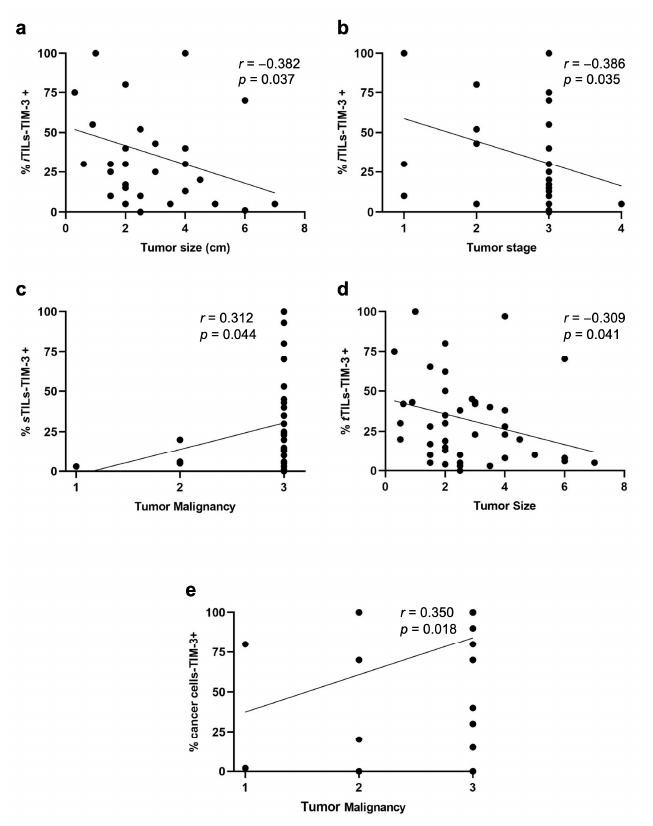
Figure 2. Spearman’s correlations of TILs-TIM-3+ with different tumor locations (intra-tumoral, stromal, and total) and cancer cells-TIM-3+ and their association with clinicopathological features. The percentage of iTILs-TIM-3+ negatively correlates with ( a ) tumor size ( r = − 0.382; p = 0.037) and ( b ) tumor stage ( r = − 0.386; p = 0.035). ( c ) The percentage of sTILs-TIM-3+ positively correlates with tumor malignancy ( r = 0.312; p = 0.044), and ( d ) the percentage of tTILs-TIM-3+ negatively correlates with the tumor size ( r = − 0.309; p = 0.041). ( e ) The percentage of cancer cells-TIM-3+ positively corre- lates with the tumor malignancy ( r = 0.350; p = 0.018).